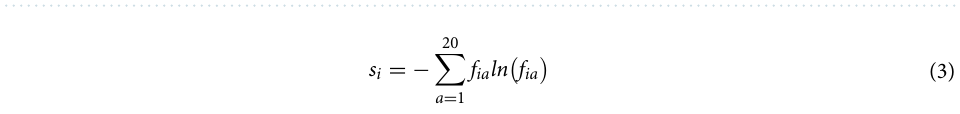
Figure 6. The correlation between the structural evolution of CaMKII and sensory behavior. Structure. The selection of the dimer (D) from other structures (M = monomer, T = tetramer) in bacteria seeded the emergence of ringed hub assemblies. The fusion with the kinase (K) domains coincided with the emergence of multicellularity (secondary structures color coded as in Fig. 1). Diversity was created by linker alternative splicing and enhanced by the generation of isoforms. Behavior. Work on model organisms suggests CaMKII evolution peaks with the development of cognitive memory. Advanced memory mechanisms (orange block). Source listed in Table